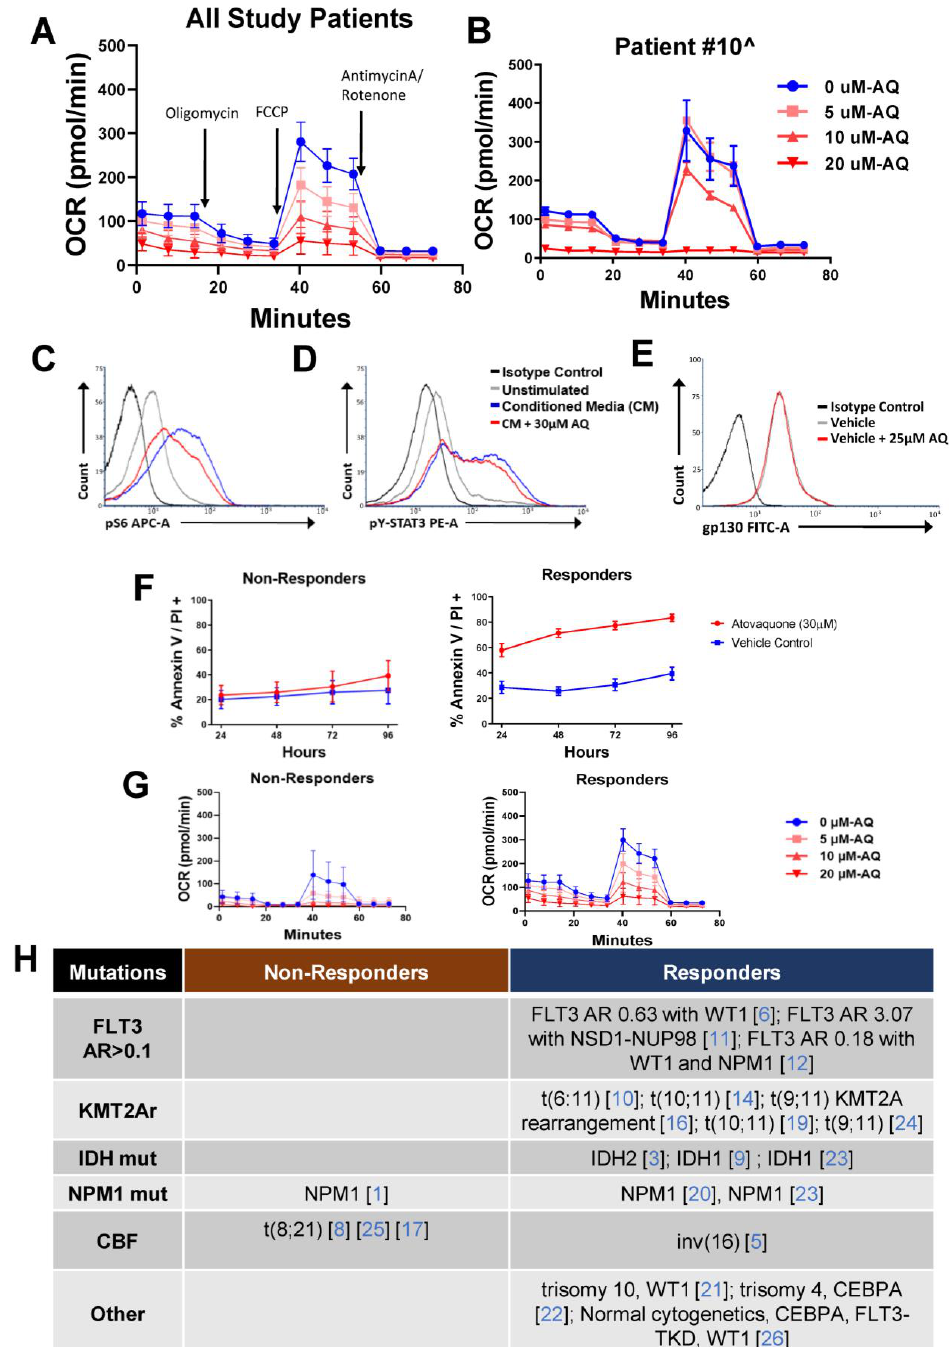
Figure 5. Atovaquone induces a dose-dependent suppression of basal and maximal mitochon- drial respiration of AML primary samples, has minimal effect on pS6 and pYSTAT3, and evalu- ation of the OCR and cytogenetics/mutations for non responders vs. responders to ex vivo AQ. ( A ) Dose-dependent reductions in the oxygen consumption rate (OCR) of primary AML cells